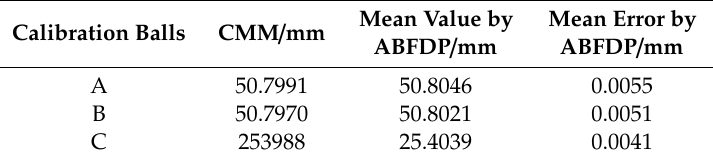
Table 1. Measurement results of calibration balls.